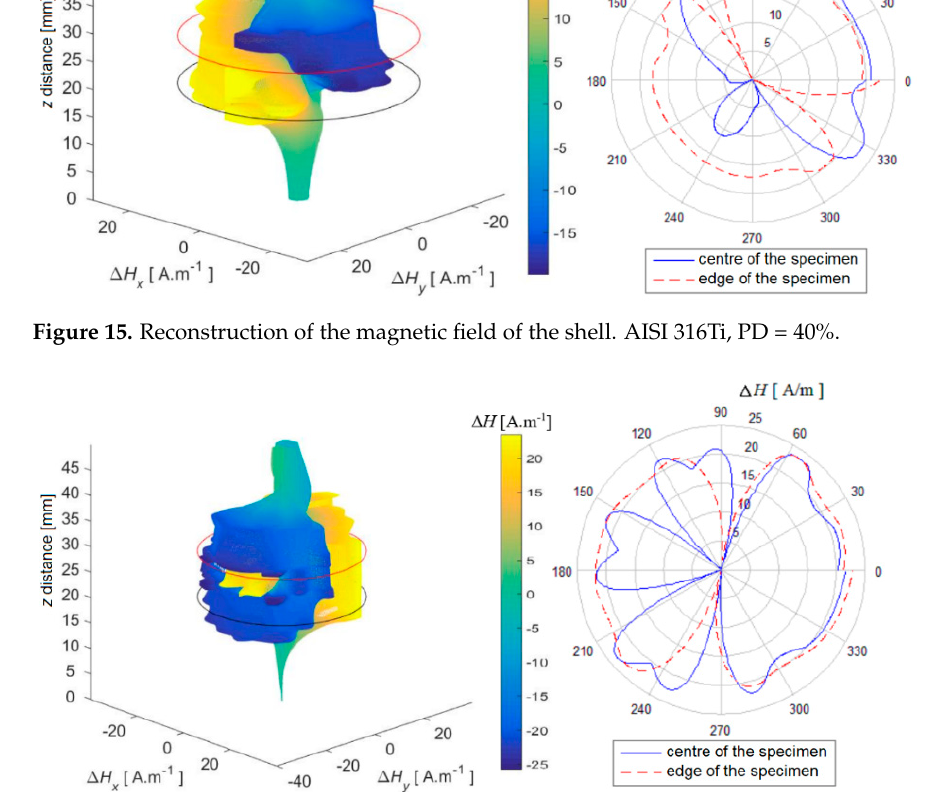
Figure 16. Reconstruction of the magnetic field of the shell. AISI 304, PD = 40%.